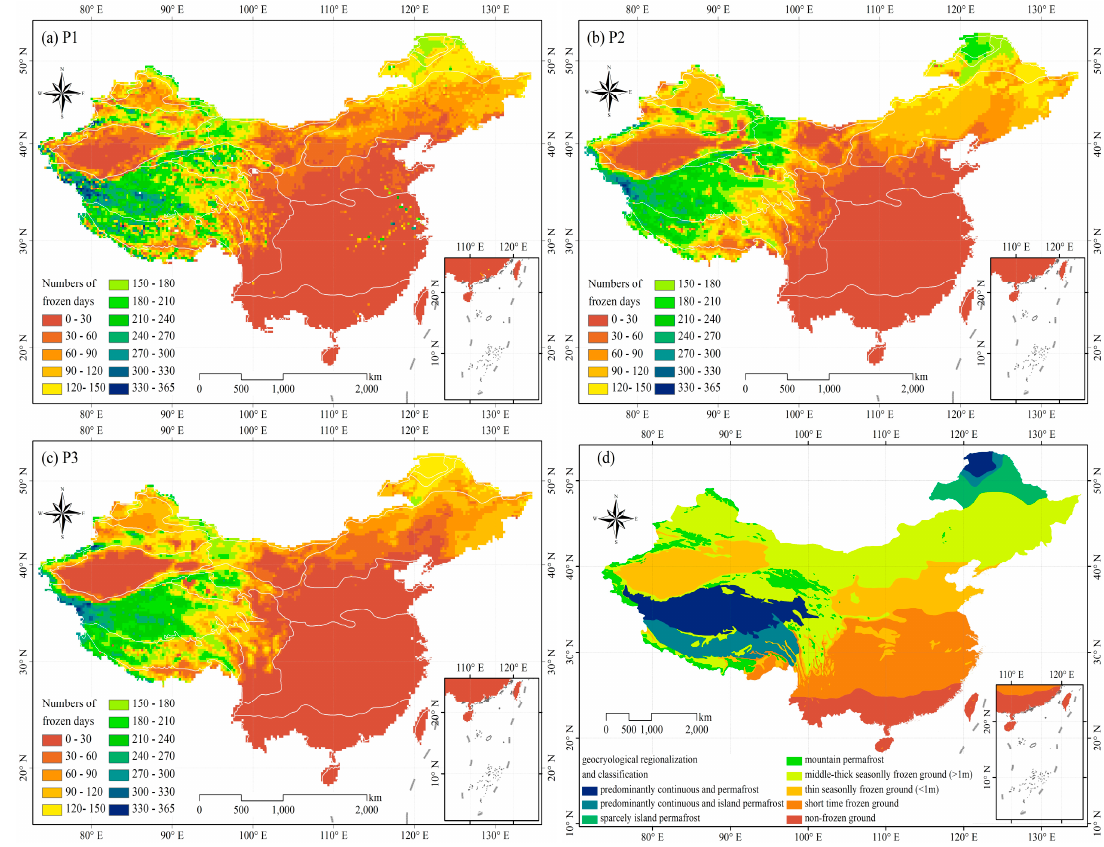
Figure 10. The numbers of days for the frozen soil in China over the study periods of P1 ( a ), P2 ( b ) and P3 ( c ), and the geocryological regionalization and classification of China ( d ) downloaded from http://www.geodata.cn.